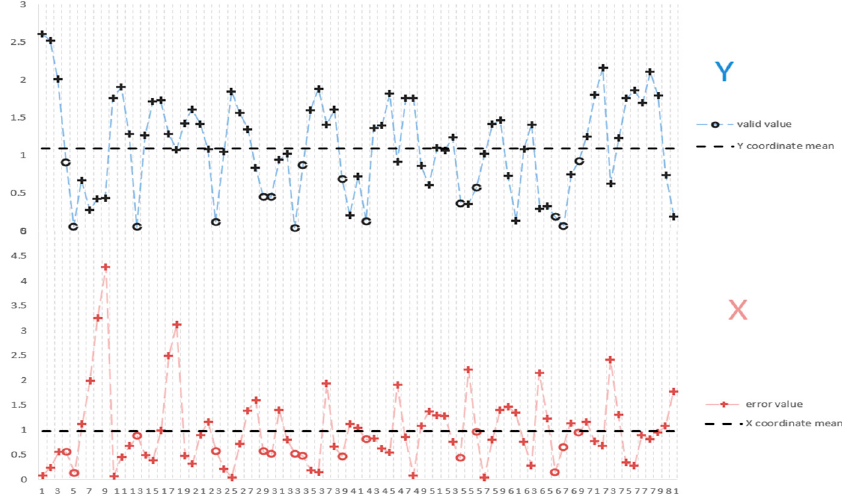
Figure 10. The circle center absolute error distribution curve along the X and Y axes.